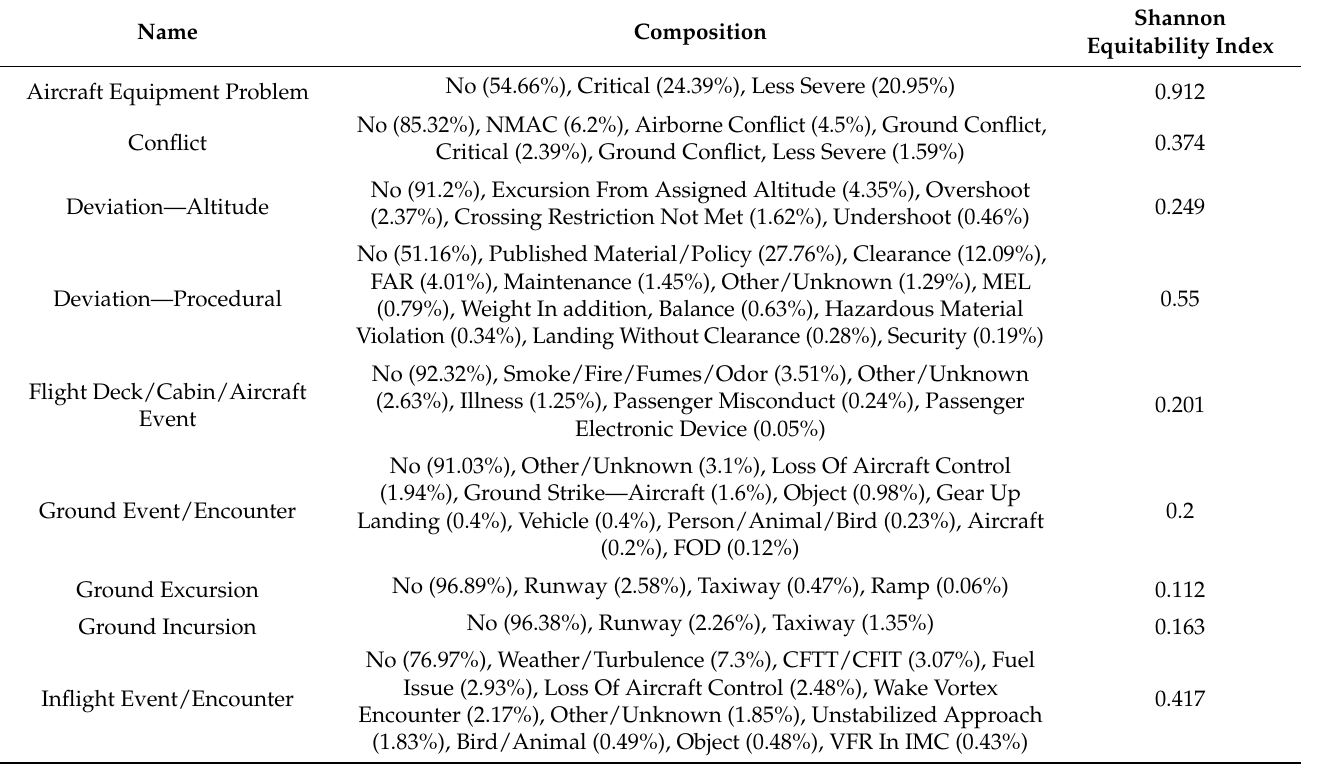
Table 1. Anomaly subcategories that are multi-classification